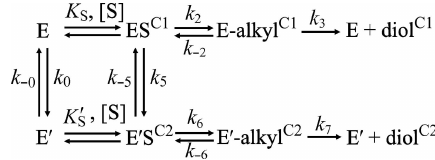
Figure 3 Model of the kinetic mechanism for epoxide hydrolysis catalyzed by StEH1. The model is based on data from pre-steady-state and steady- state kinetics and the enantiomeric ratios of the product